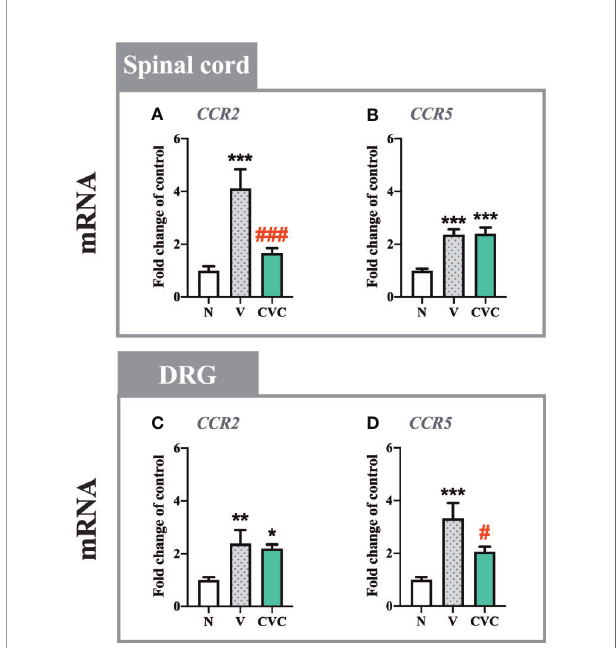
FIGURE 2 | Changes in mRNA levels of CCR2 and CCR5 in the spinal cord (A, B) and DRG (C, D) on day 7 post CCI after repeated vehicle or cenicriviroc (20 µg/5 µl, i.t. ) administrations, measured using RT-qPCR method. Data are presented as the mean ± SEM (n = 6 – 8 per group). Intergroup differences were analyzed by ANOVA with Bonferroni ’ s multiple comparisons test. ***p < 0.001, **p < 0.01, *p < 0.05 indicate differences between naive and V-treated/CVC-treated CCI-exposed rats; ### p < 0.001, # p < 0.05 indicate differences between V-treated and CVC-treated CCI- exposed rats. CCI, chronic constriction injury; CVC, cenicriviroc; N, naive; V,